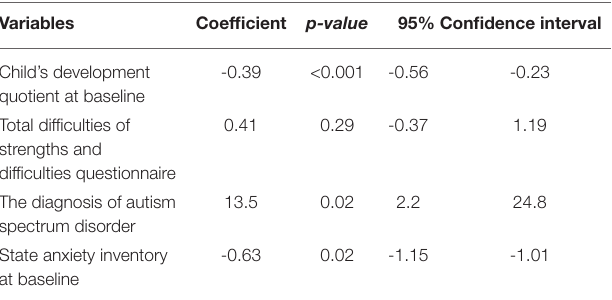
TABLE 3 | Linear regression predicting child’s development quotient gain by the